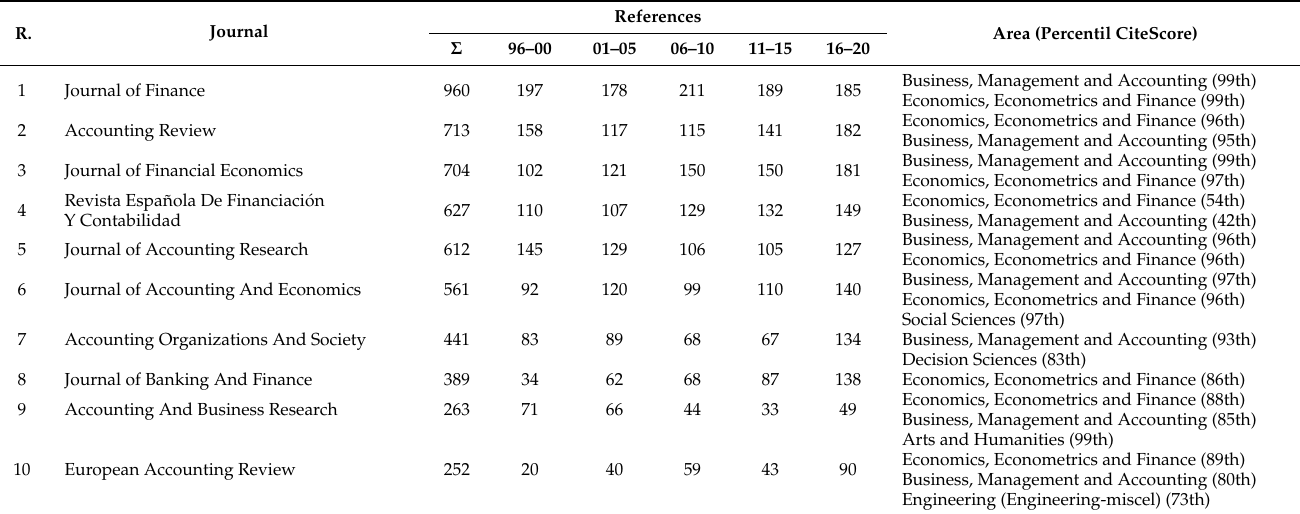
Table 11. Main journals used as references in articles published in SJFA.